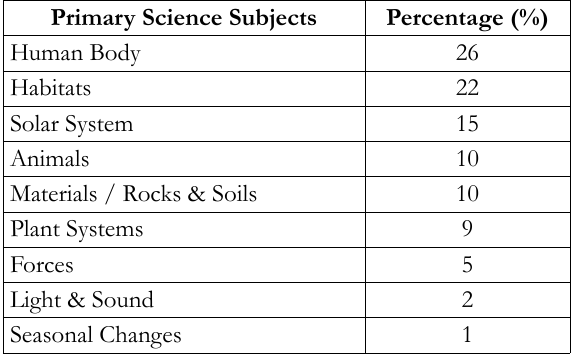
Table 15. Percentage of teacher responses using AR for Primary Science Subjects (Questionnaire) Challenges of AR